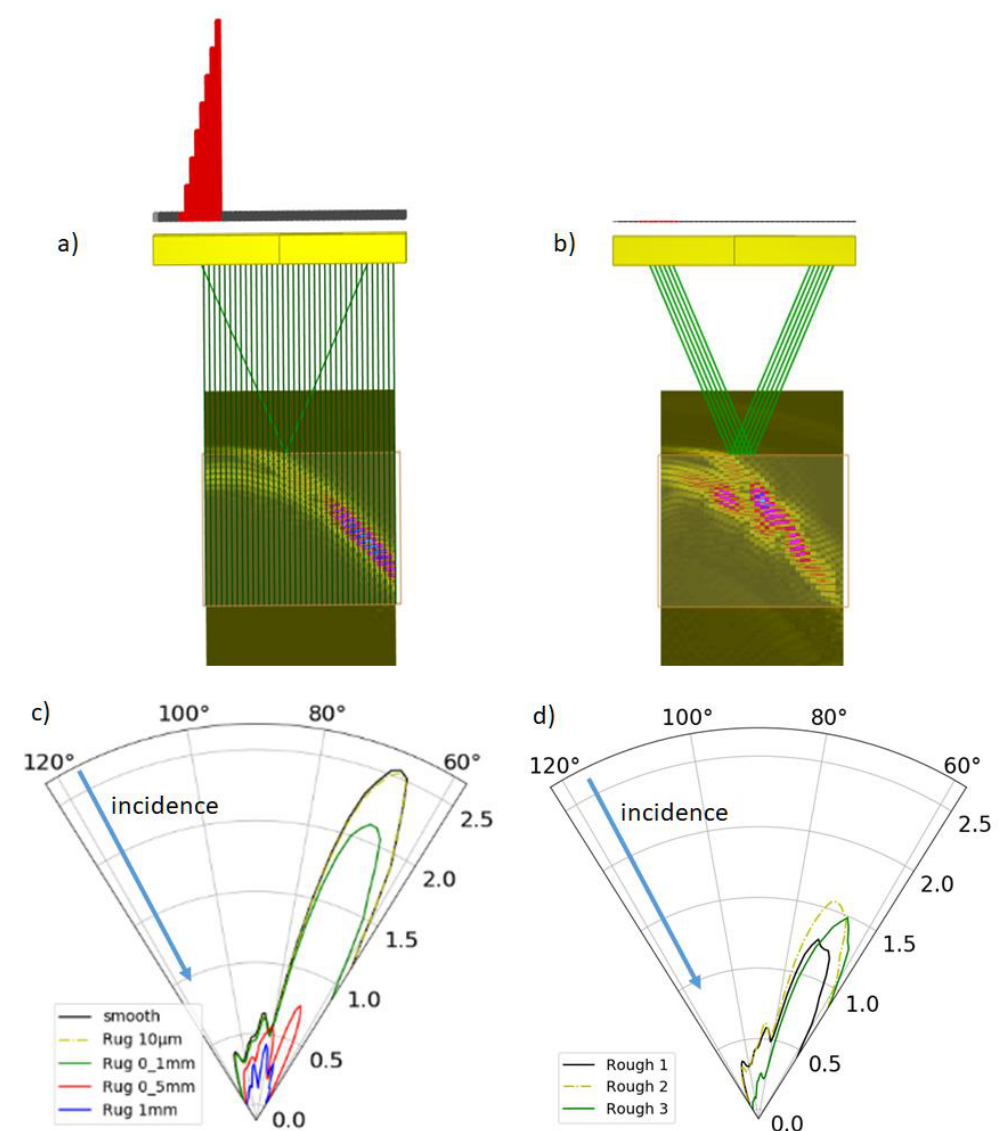
Figure 7. Ultrasonic inspection of a planar steel component (orange box) immersed in water (water path 25 mm) at frequency = 2 MHz (wavelength λ = 0.75 mm): Bscans simulated with KA for a ( a ) smooth and ( b ) a rough entry surface (RMS surface height σ = 1 mm and correlation lengths L x = L y = 10 mm). Scattering patterns (maximum of the echographic signal versus observation angle) ( c ) for di ff erent roughnesses (smooth, 10 µ m, 0.1, 0.5 and 1 mm) and ( d ) for three di ff erent generated rough surfaces of the same statistical properties (roughness σ = 0.2 mm and correlation lengths L x = L y = 10 mm).